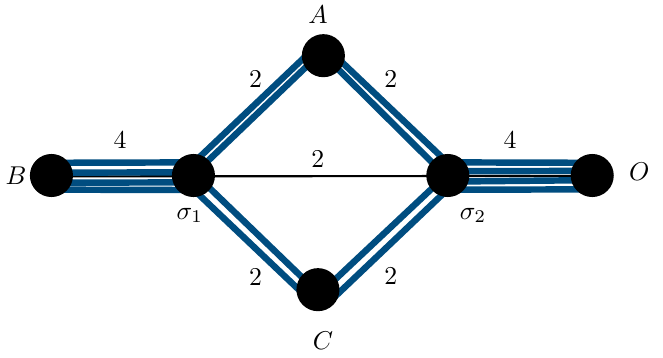
Figure 12 . An optimal 2-thread configuration µ ∗ of g for the program (2.13). The corresponding entropy vector of the configuration is S 3 = { 4 , 4 , 4; 4 , 8 , 4; 4 } . The entropies S µ red do not match S 3 . This is a consequence of theorem 2 which states only single party entropies g are guaranteed to be locked. Note the corresponding K -basis vector of the thread configuration is = { 2 , 0 , 2 , 2 , 0 , 2; 0 } which matches the number of each thread K 3 µ